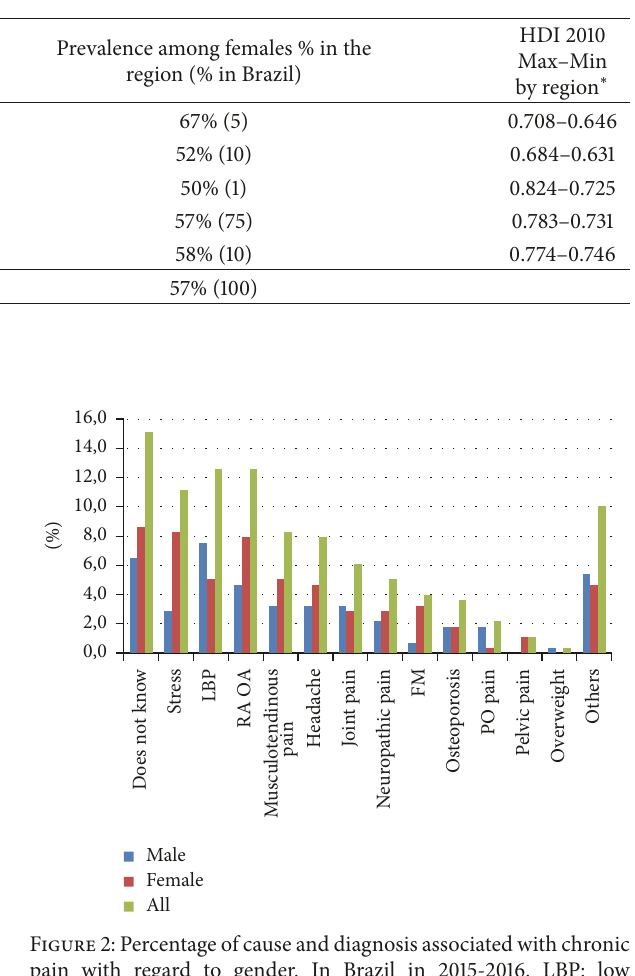
Table 2: Chronic pain prevalence by gender and human development index by region.